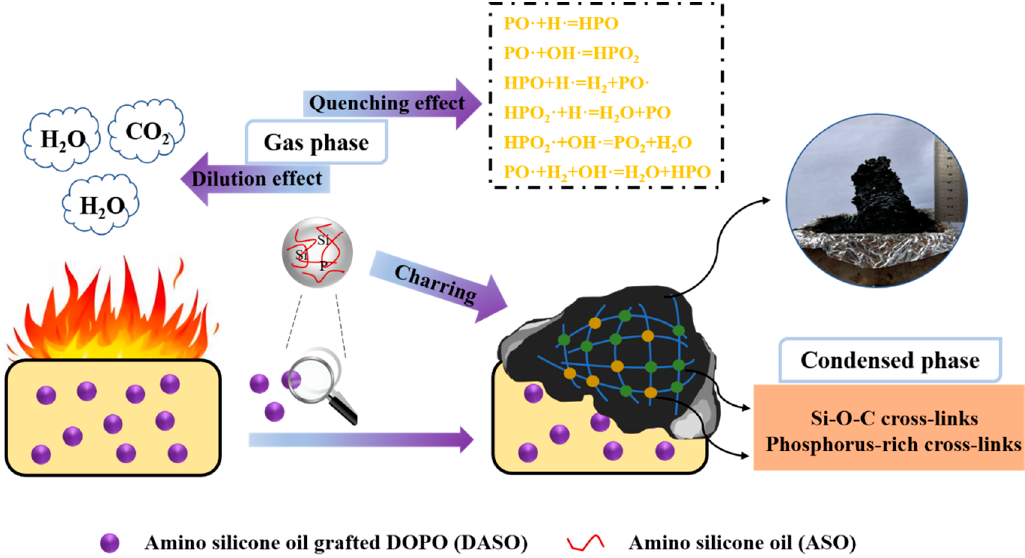
Scheme 2. Flame-retardant mechanism of FRPC composites.